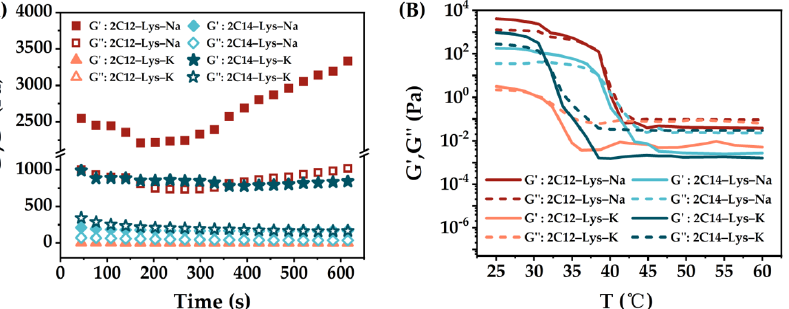
Figure 10. Rheological behaviors of gels formed by 2C12-Lys-Na, 2C12-Lys-K, 2C14-Lys-Na and 2C14-Lys-K in t -butanol–water mixtures: ( A ) Variation of storage modulus (G’) and loss modulus (G”) with time; ( B ) dependence of the storage modulus (G’) and loss modulus (G”) with the temper- ature. Table 3. The phase transition temperature of gels formed by L -lysine-based gelators. Solvents